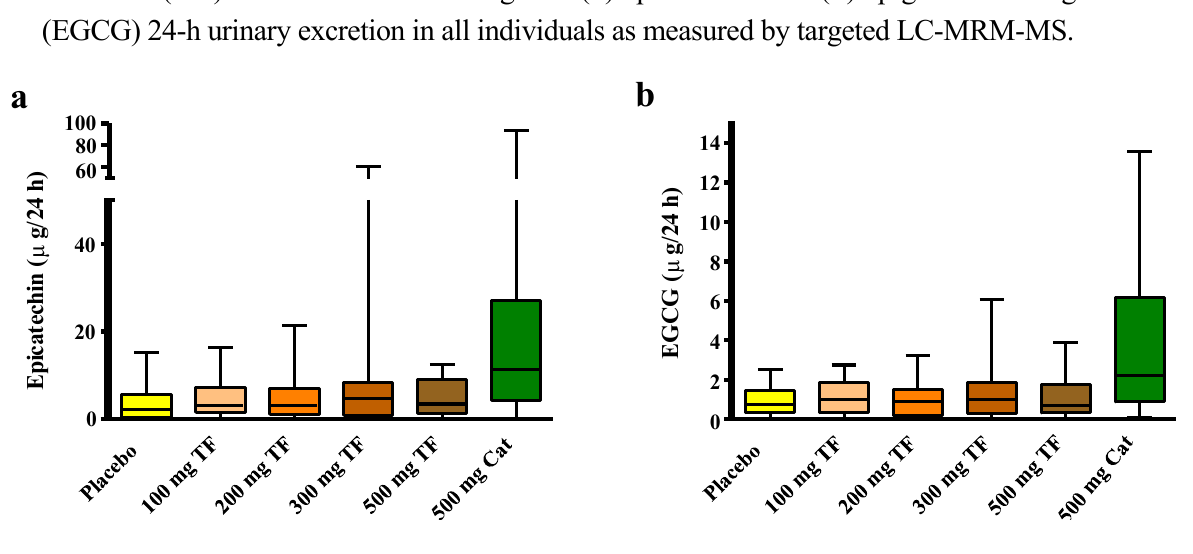
Figure 3. Boxplots (interquartile range, whiskers are min to max) of theaflavins (TF)